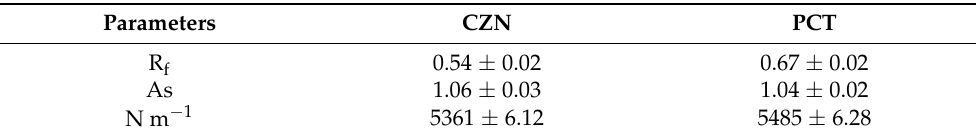
Table 2. The values of system suitability parameters for CZN and PCT for the HPTLC-UV methodol- ogy (mean ± SD; n = 3).